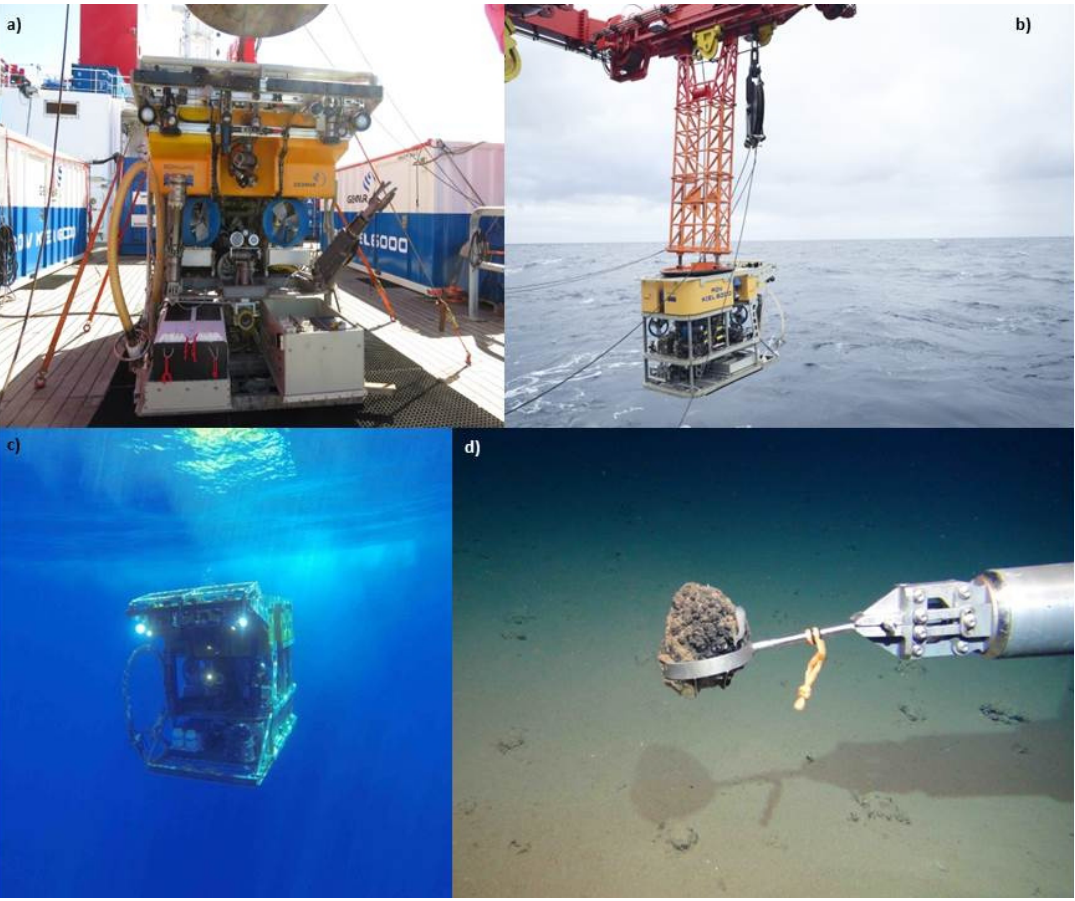
Figure 1: ROV KIEL 6000, a) front view of the vehicle on deck of RV "SONNE", b) deployed with A-frame and LARS, c) underwater, d) using the ORION manipulator to sample a manganese nodule. (Photos: a, c, d) GEOMAR ROV Team, b) Sven